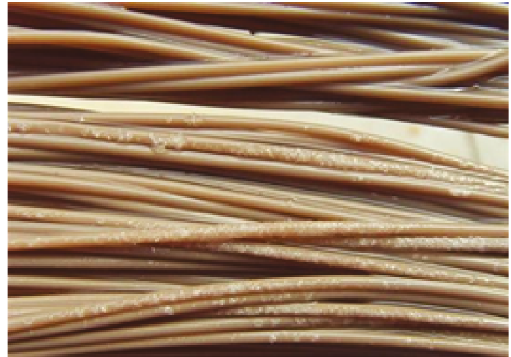
Figure 7: The photograph of NaCl crystallization on the surface of the